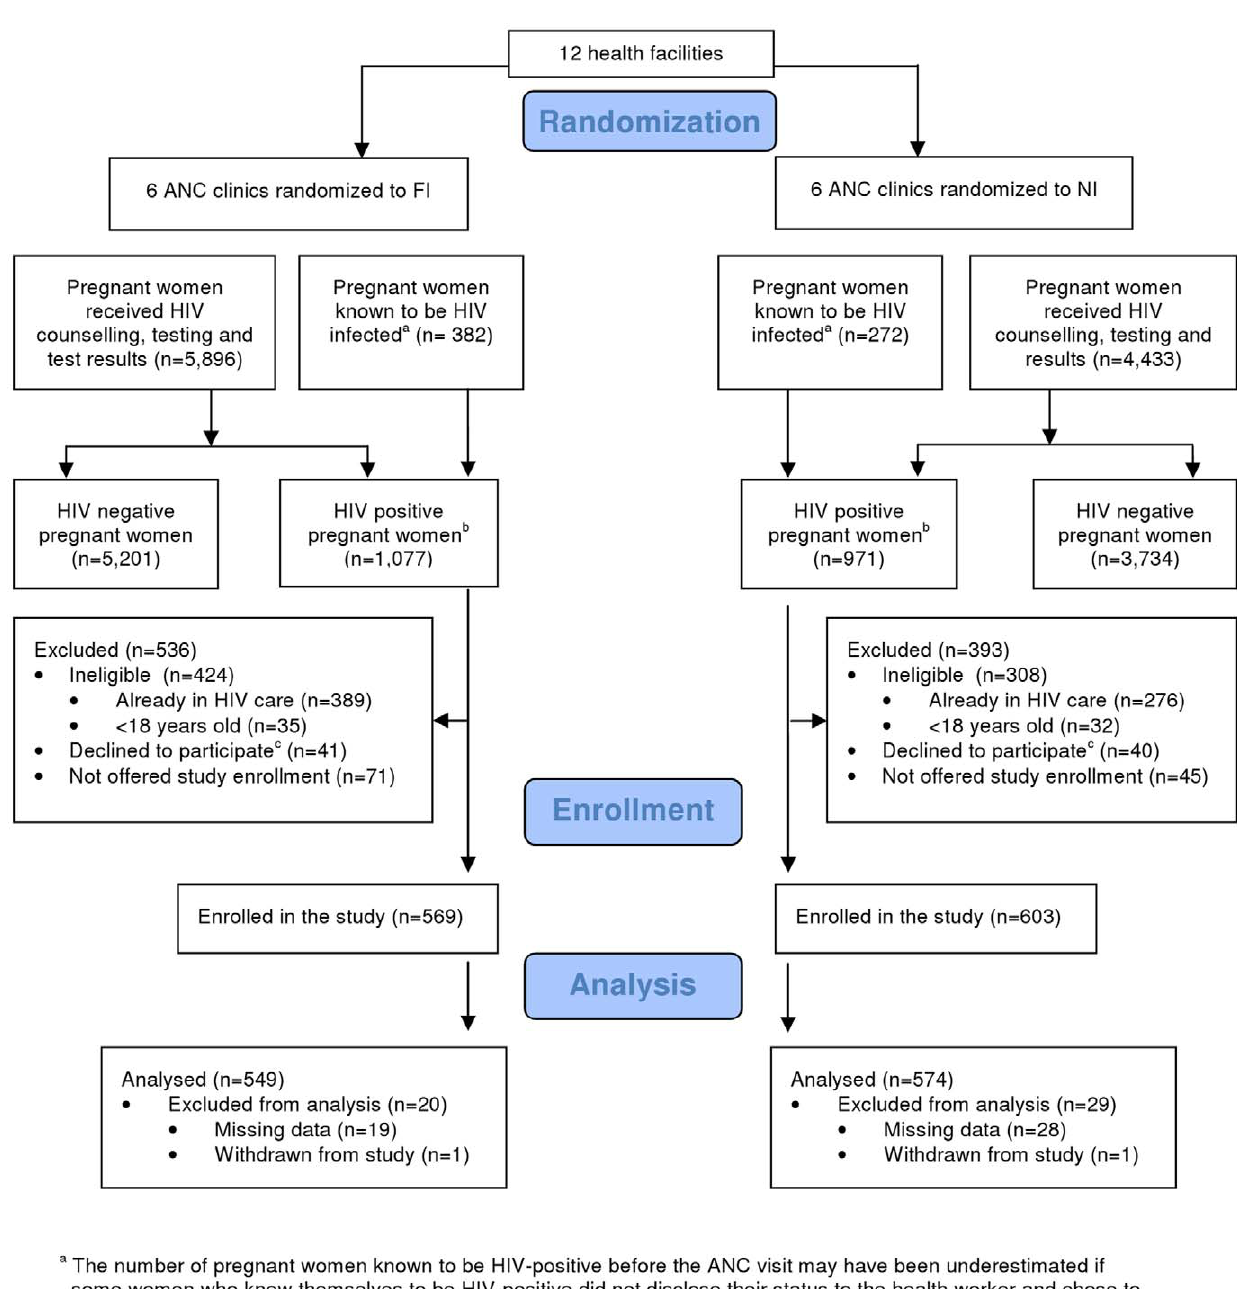
Figure 2. Consort Diagram. The flow diagram of clusters and individuals through the cluster randomized trial. A total of 1,172 HIV-positive pregnant women were enrolled in the study during the period June 2009–March 2011. doi:10.1371/journal.pone.0044181.g002 clinic flow and logistics for FI or NI services, informed consent procedures, and participant eligibility criteria. Clinical trainings covered the components of high quality ANC, PMTCT, and HIV